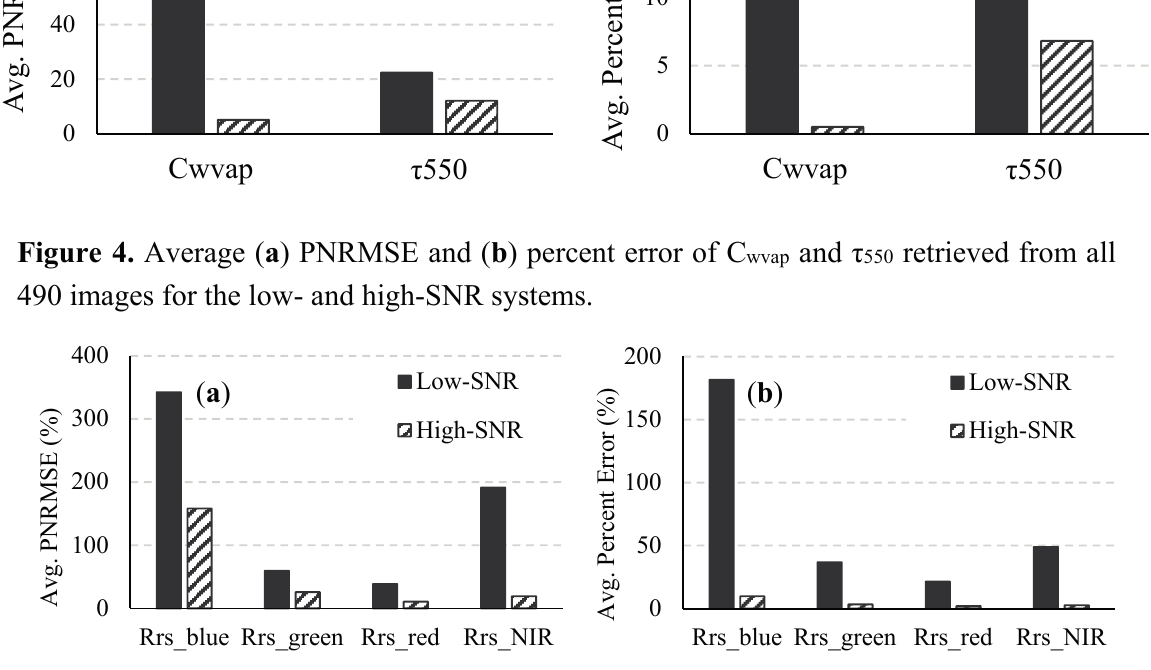
Figure 5. Average ( a ) PNRMSE and ( b ) percent error of the reflectances retrieved from all 490 images for the low- and high-SNR